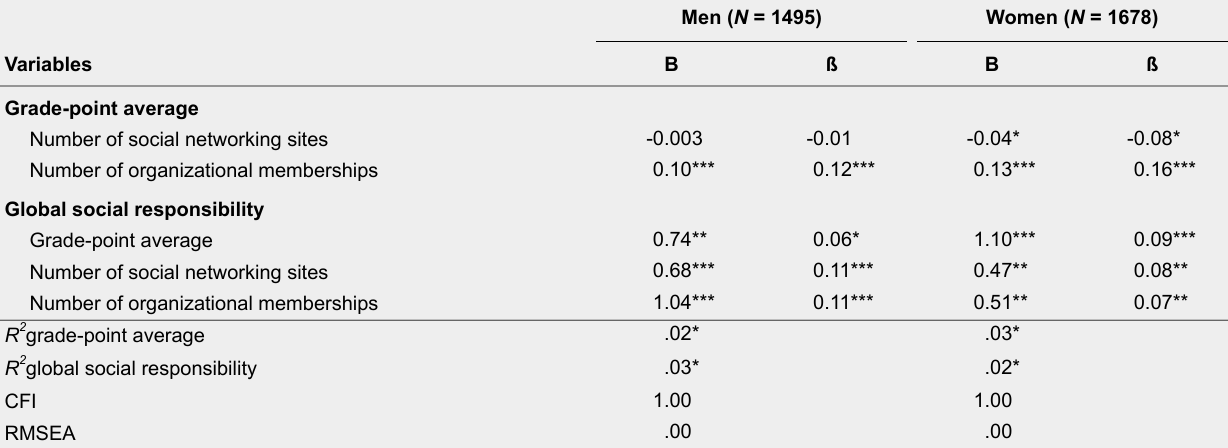
SEM Coefficients for the Structural Relationships Between Assessed Variables Among Men and